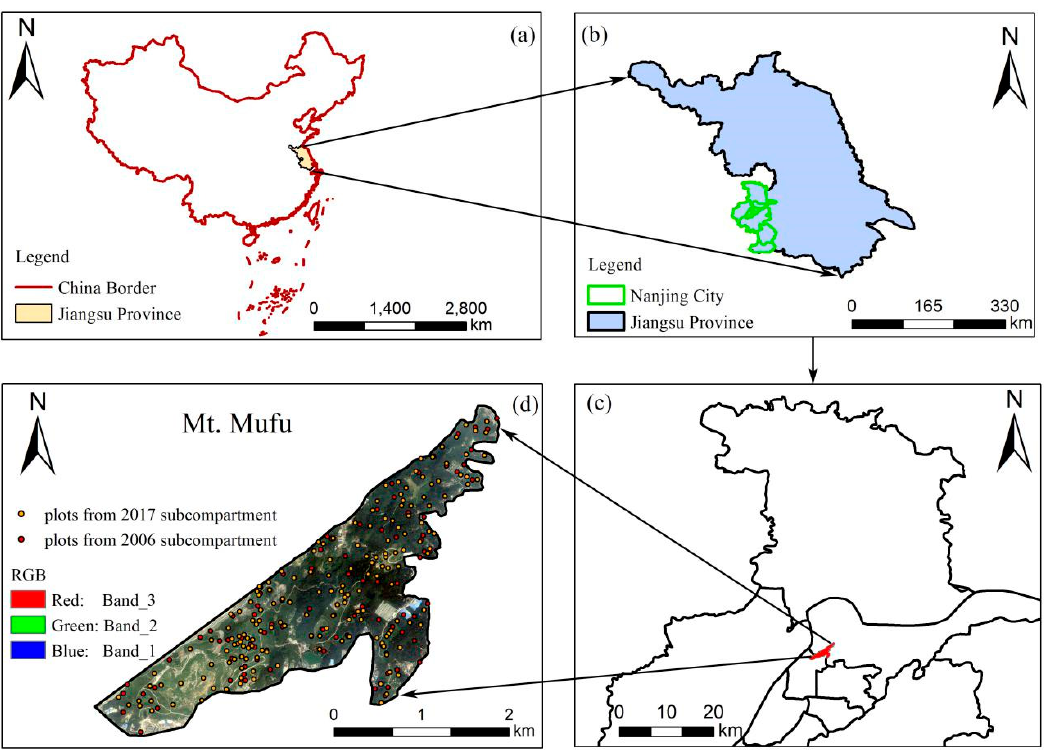
Figure 1. Spatial location of Mt. Mufu in Nanjing City, Jiangsu Province, China ( a – c ); the true color composite of Mt. Mufu in 2009 (Band_3: red, Band_2: green, Band_1: blue), and the spatial distribution of field plots in 2006 and 2017 ( d ).